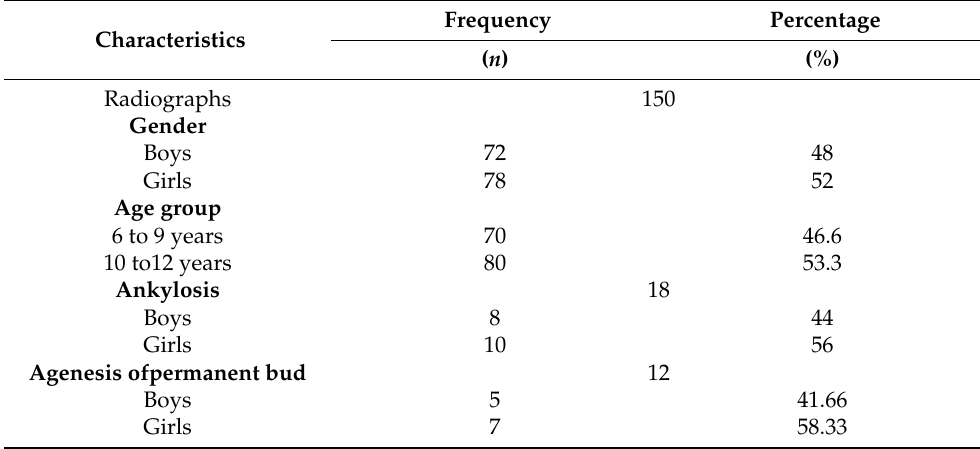
Table 1. The characteristics of the subjects analyzed in the study.